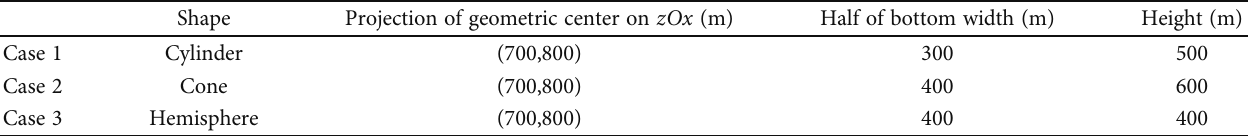
Table 1: Shapes and positions of obstacles in example 1.